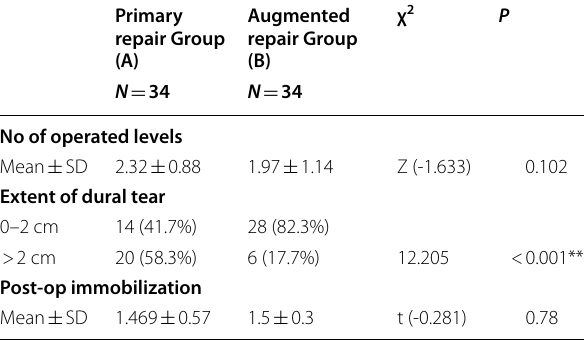
* T independent sample t-test p < 0.05 is statistically significant